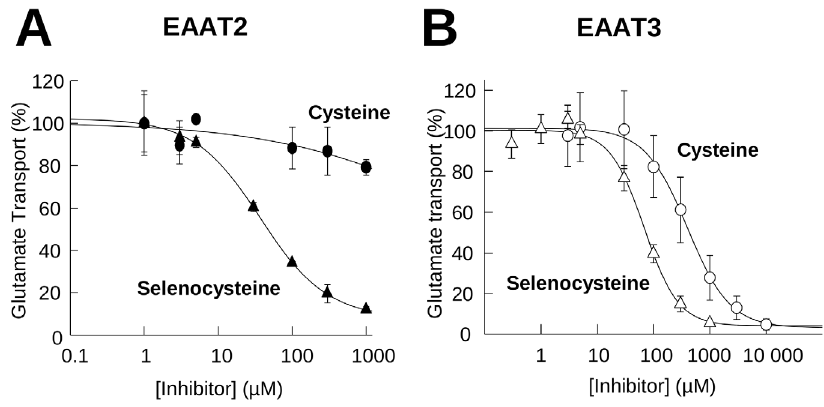
Figure 3. Inhibition of glutamate transport by L-Selenocysteine and L-Cysteine for EAAT 2 and EAAT 3. Inhibition of radiolabeled glutamate uptake using varying concentrations of L-cysteine (circles) or L-selenocysteine (triangles) in HEK293 cells expressing EAAT2 ( A, n . 5 for each data point) or EAAT3 ( B, n . 5 for each data point). Data are represented as the mean and the standard error of the mean with non-linear curve fit to calculate the IC 50